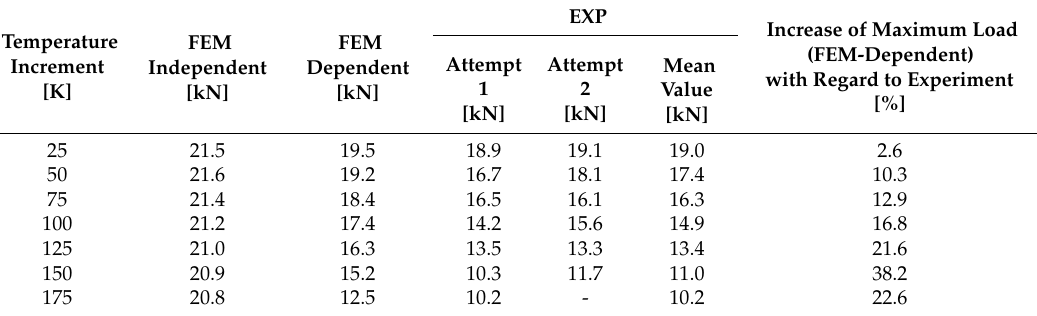
Table 3. The load-carrying capacity based on FEM and the experiment (EXP).